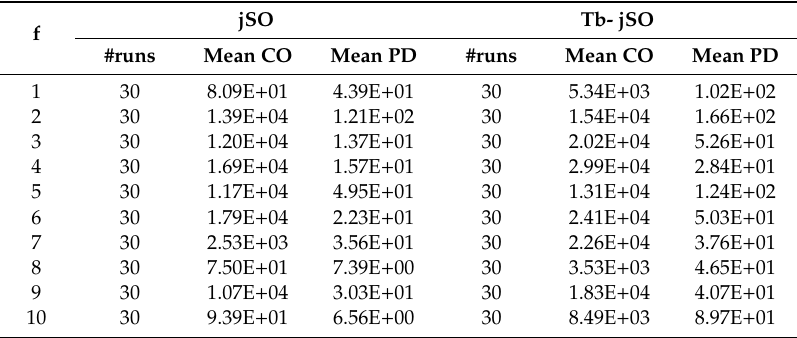
Table 33. Clustering and population diversity of jSO and Tb-jSO on the CEC2020 in 15 D .